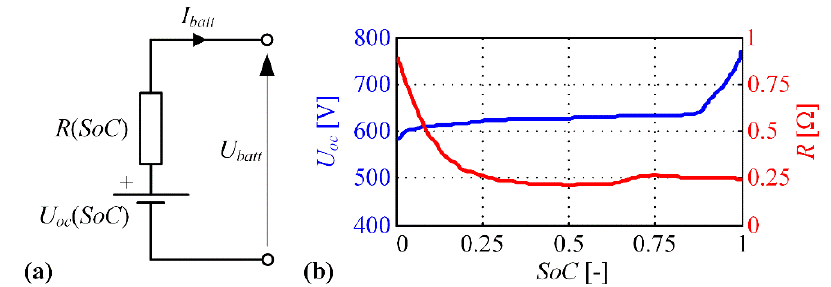
Figure 2. Engine specific fuel consumption map ( a ), and electric machine (M / G) machine e ffi ciency map ( b ), given along with maximum torque lines (denoted in blue).